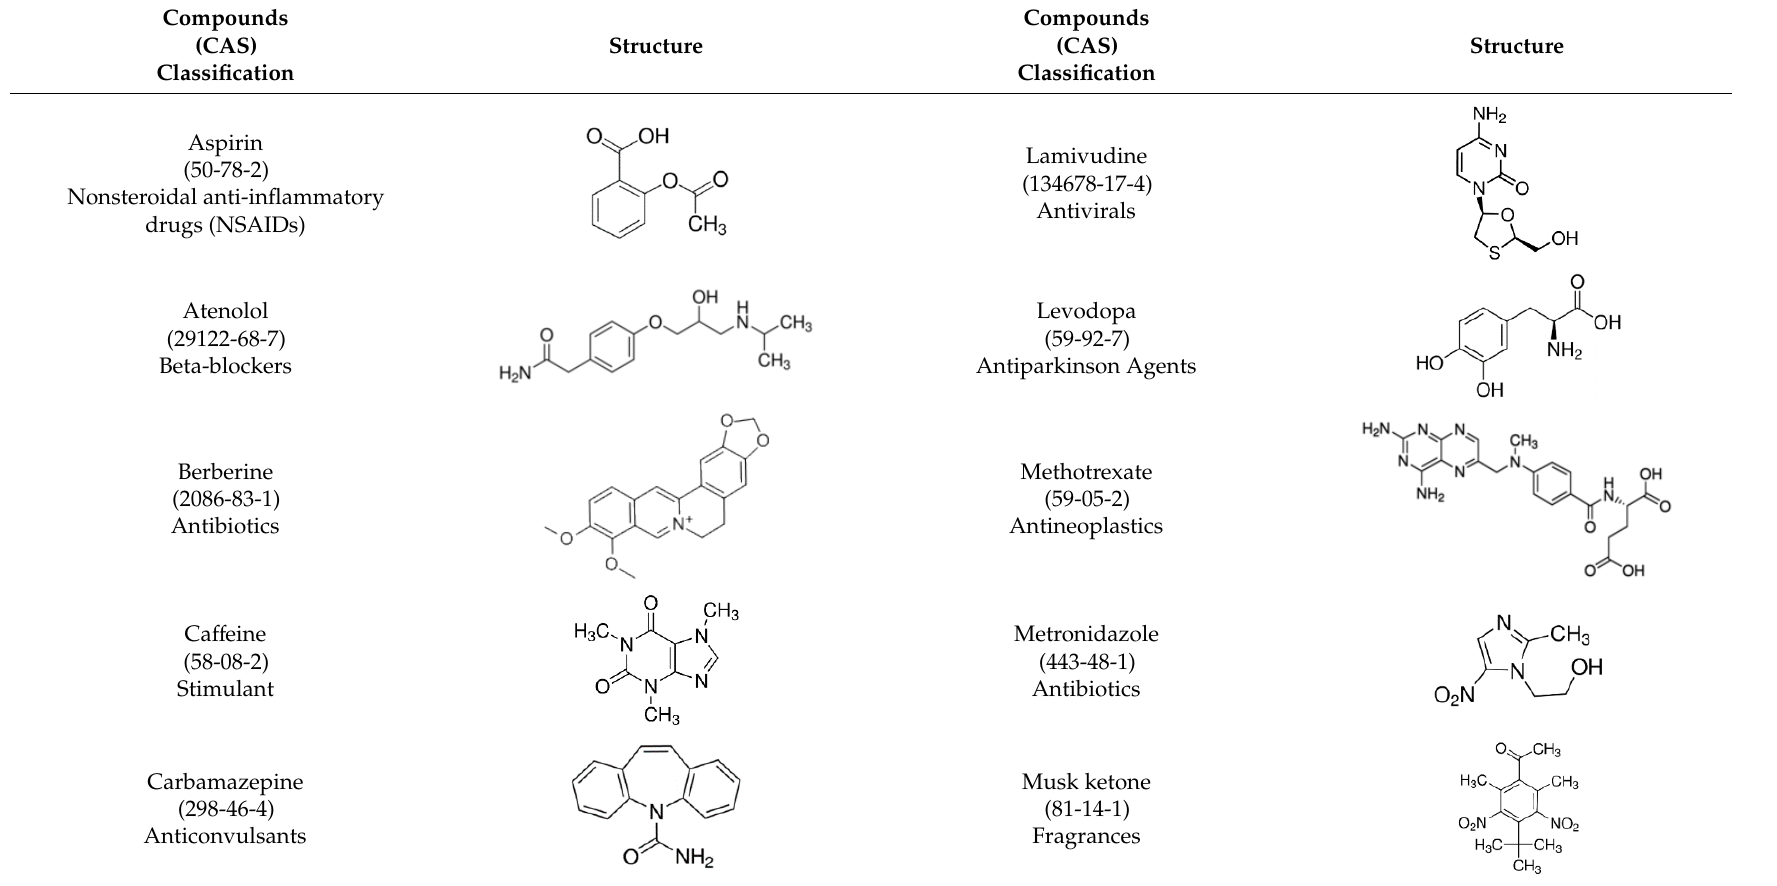
Table 1. Structures, chemical abstracts service registry number (CAS), and classification for the target pharmaceuticals and personal care products (PPCPs) selected for this study.